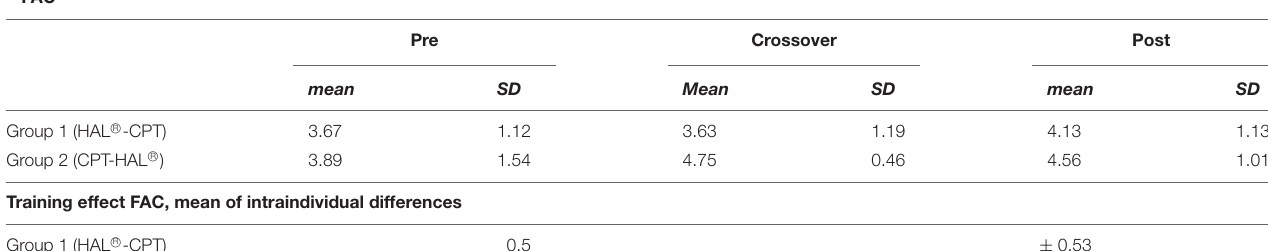
TABLE 4 | Data sheet with mean values for functional ambulatory categories and Berg-Balance-Scale. FAC Pre